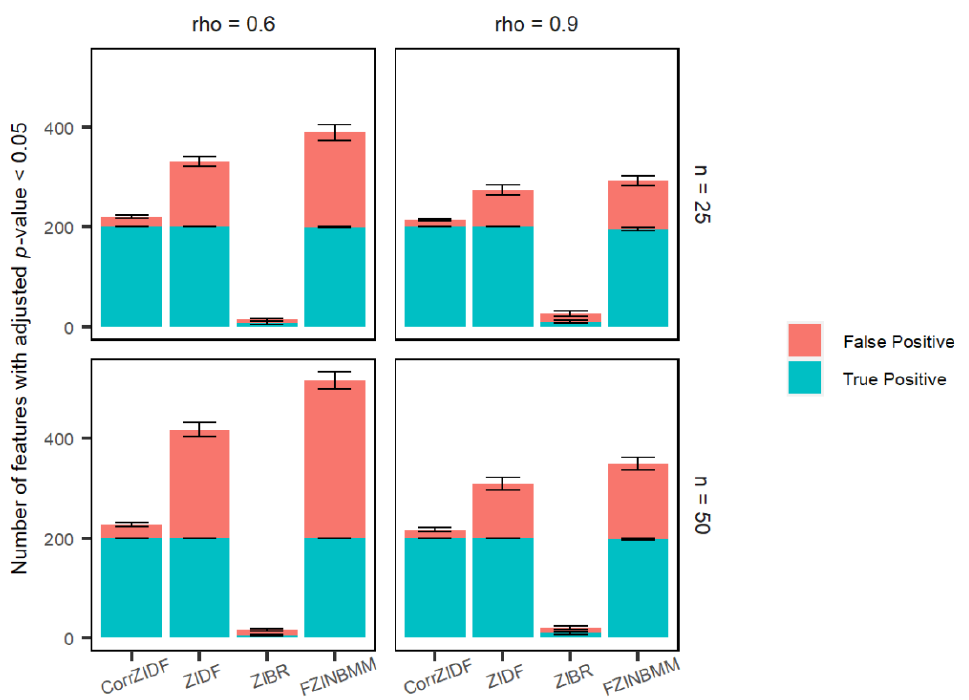
Figure 3. Bar plots of the numbers of detected true and false positives under various settings with 1000 features and 20 replicated simulations. Each bar represents the total number of features that are detected as statistically significant post BH adjustment, and the short error bars represent the standard deviation from 20 replications. Note: the true number of DAFs in the simulation is 200. Assume AR (1) correlation structure across different sampling points.